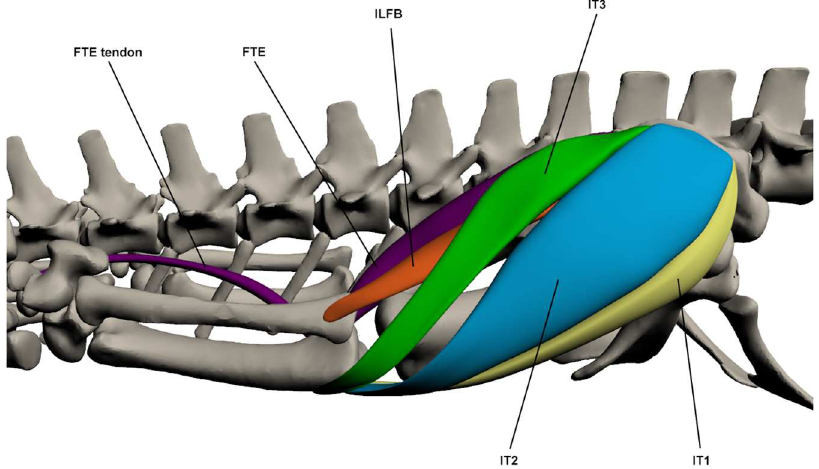
Fig 13. Superficial dorsal muscles of the upper hindlimb. ILFB: Iliofibularis ,FTE: Flexor tibialisexternus , IT1-3: Iliotibialis1–3 .